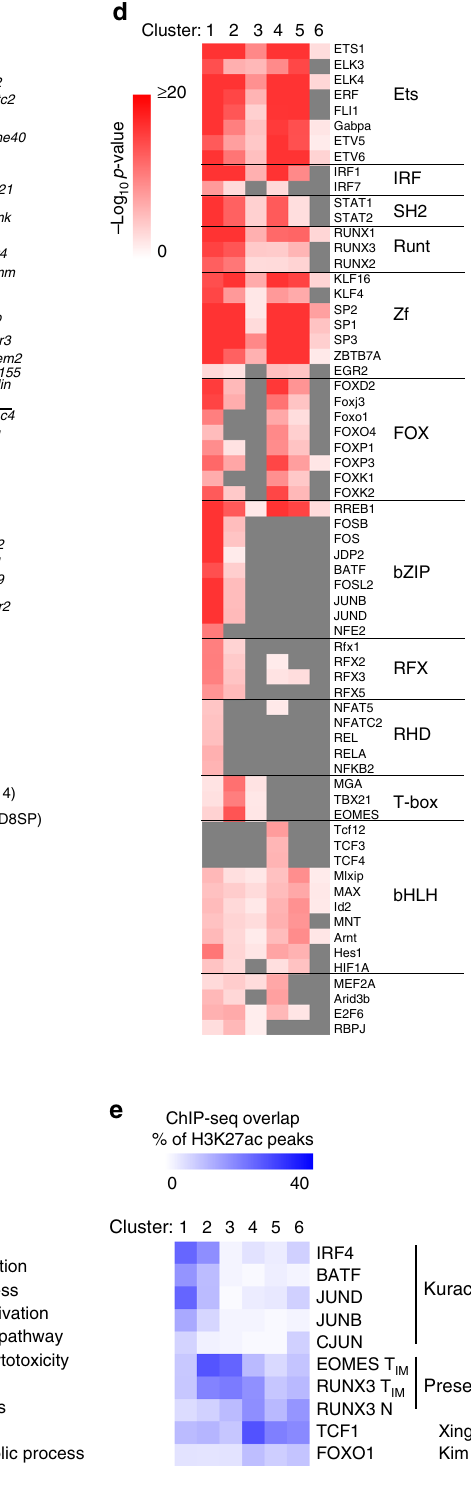
ectopic EOMES expression in developing CD8SP thymocytes is suf fi cient to drive most phenotypic, functional, and transcrip- tional features of T IM cells.